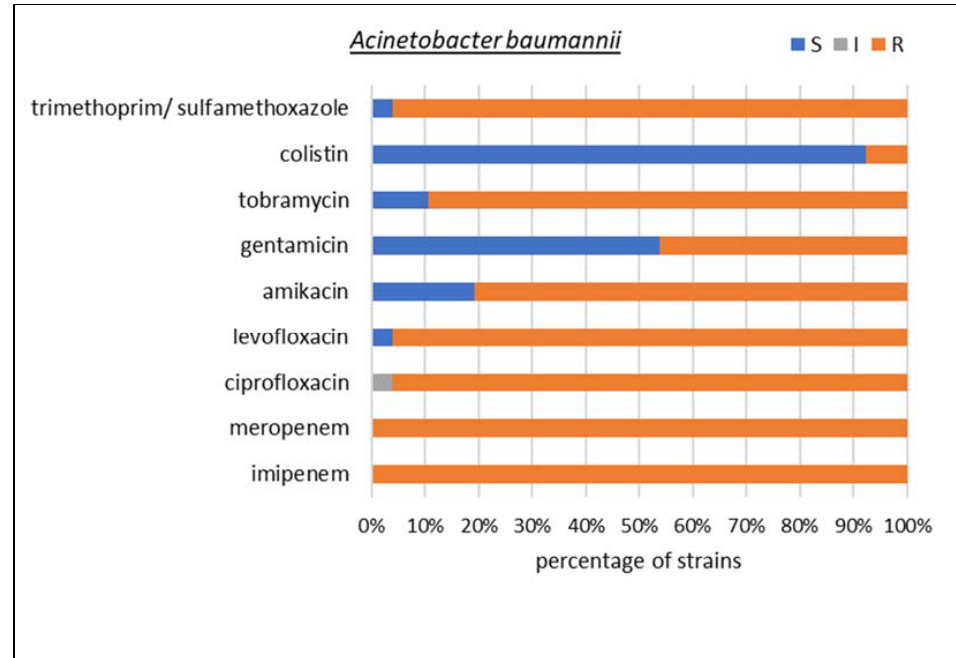
Figure 7. Drug susceptibility of the studied Acinetobacter baumannii strains producing car- bapenemases ( n = 26).